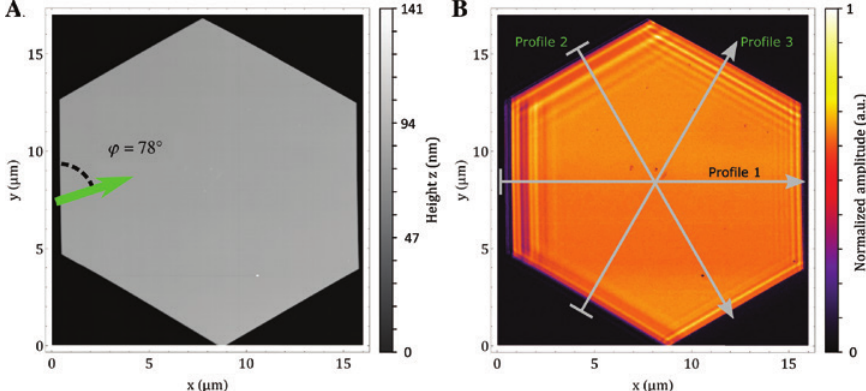
Figure 6: Topographic and near-field optical signals at an illumination wavelength of 521 nm. (A) AFM and (B) s-SNOM images of a monocrystalline gold platelet.